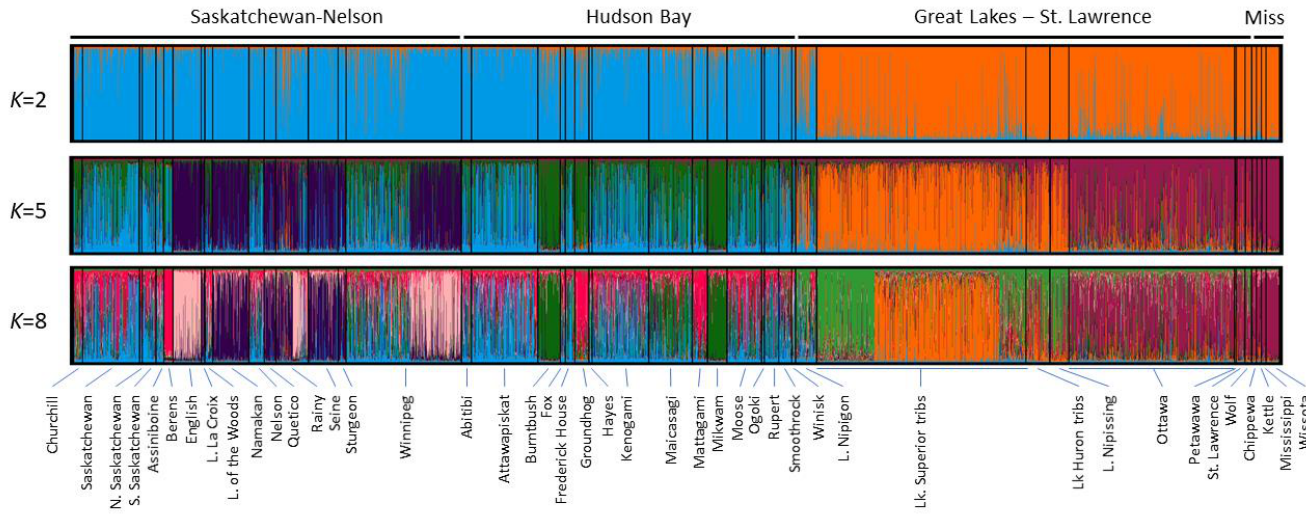
Figure 2. Structure assignment plots for individual-based analyses of lake sturgeon across the species range for different solutions of K (number of genetic groups present), showing individual membership assignments to multiple groups for values of K = 2, 5, and 8 without using sampling locations as a priori information to identify putative genetic groups.